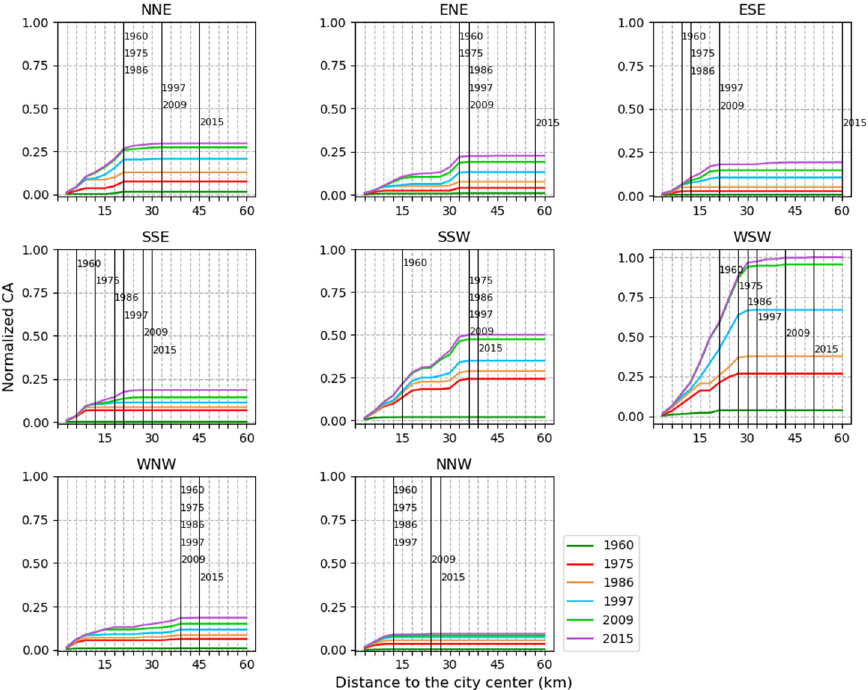
Figure 4. The total area of urban land in different directions and within concentric rings from 1960 to 2015. The x-axis represents the distances to the city center. The y-axis represents the normalized value of the metric. The black vertical line represents the distance where the metric value became stable for each year.